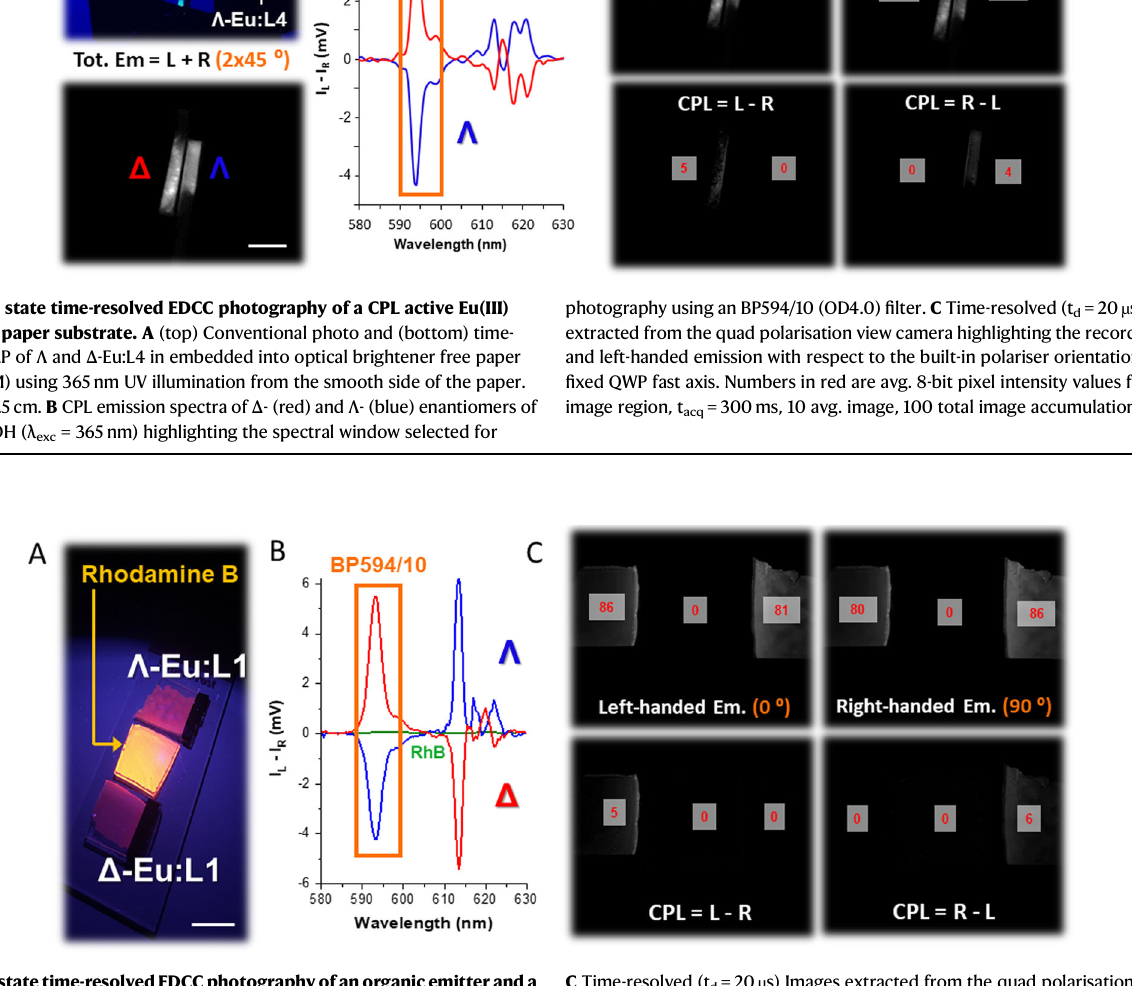
Fig.5|Solidstatetime-resolvedEDCCphotographyofanorganicemitteranda CPL active Eu(III) complex. A Conventional photo of rhodamine B (RhB) and Λ - and Δ -Eu:L1 in embedded into a PMMA matrix (C=3×10 − 6 M) using 365nm UV illumination. Scale bar=1cm. B CPL emission spectra of (green) rhodamine B, Δ - (red) and Λ - (blue) enantiomers of Eu:L1 in PMMA ( λ ex = 365nm) highlighting the spectral window selected for photography using an BP594/10 (OD4.0) fi lter.